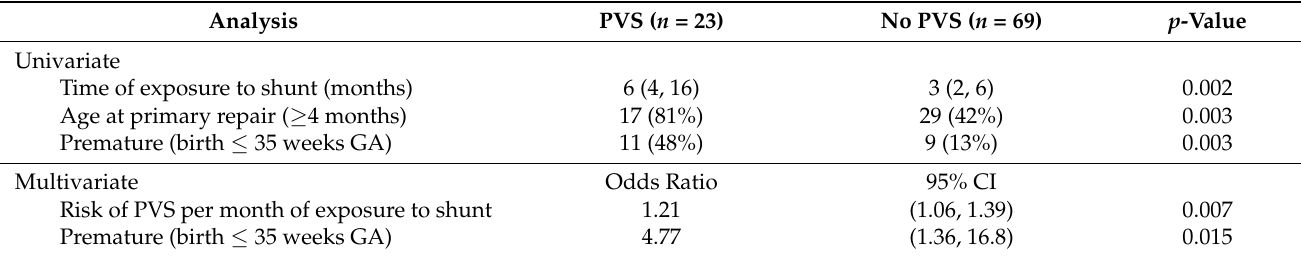
Table 2. Univariate and Multivariate Analyses of Primary and Secondary Predictors.